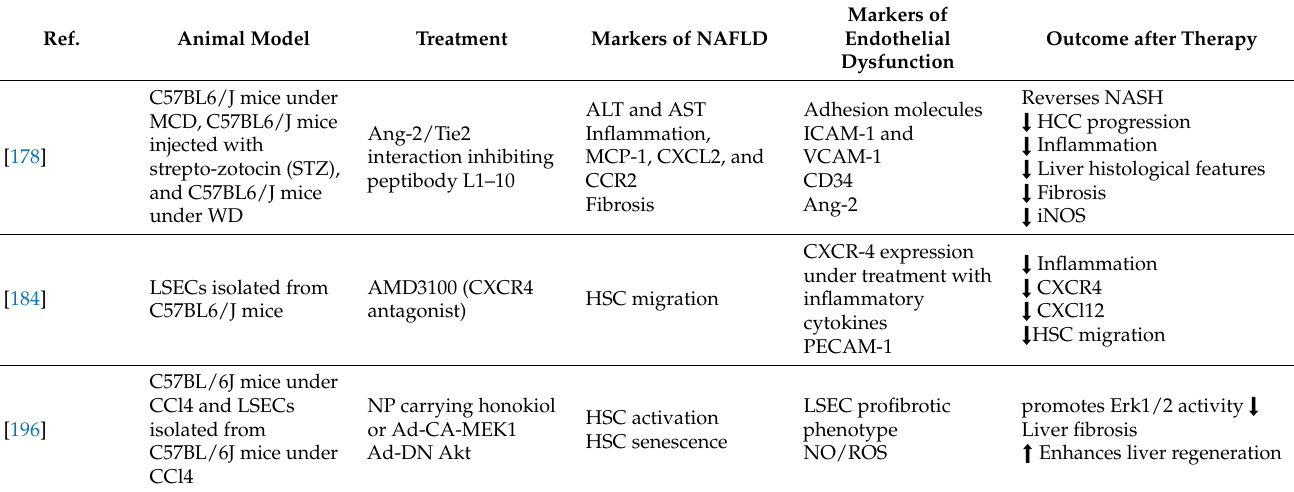
Table 1. Studies targeting endothelial cells as a therapeutic strategy in animal models of